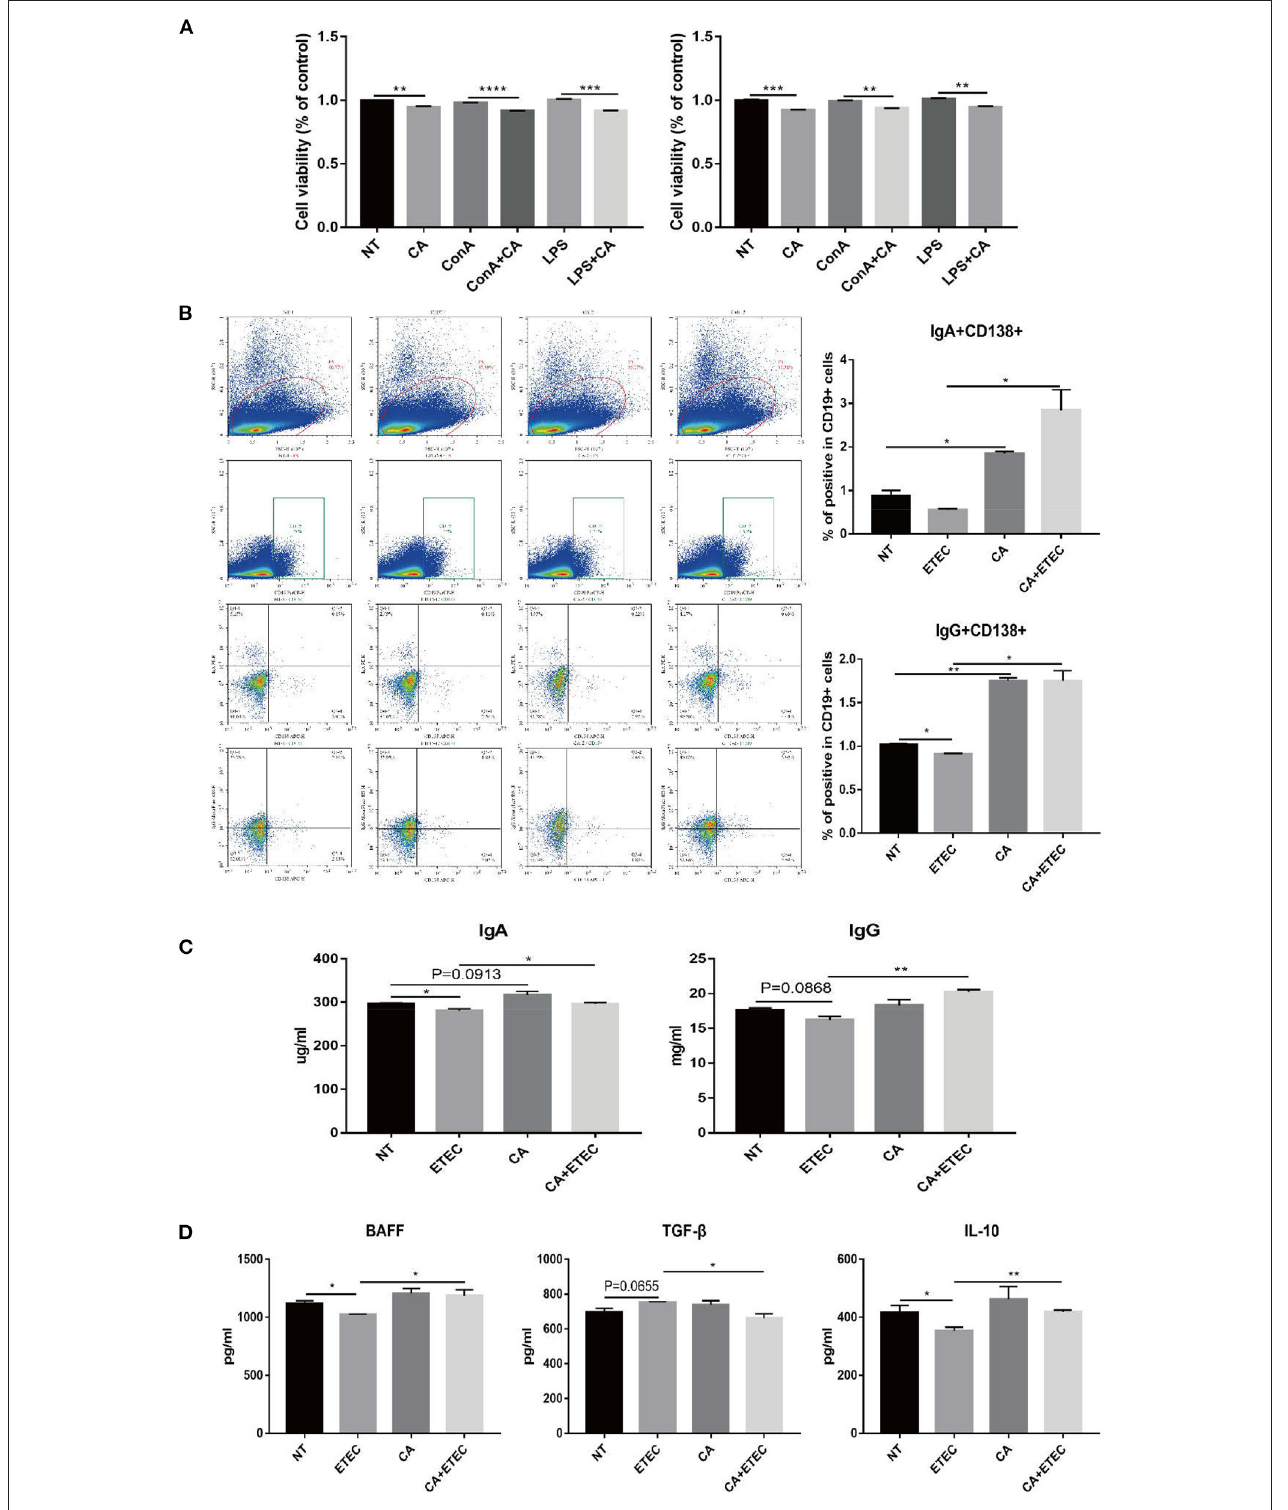
FIGURE 4 | Citric acid (CA) inhibited B cell proliferation but promoted IgA + and IgG + B cells in mouse spleen. (A) The effect of CA on the proliferation of mouse splenic B cells was detected by Cell Counting Kit-8 Assay. Cells treated with 20 µ g/mL ConA were used as a positive control for T cell proliferation, and 1 µ g/mL